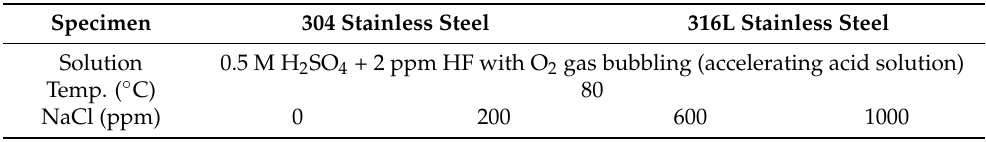
Table 2. Experimental conditions for a potentiodynamic polarization experiments with chloride